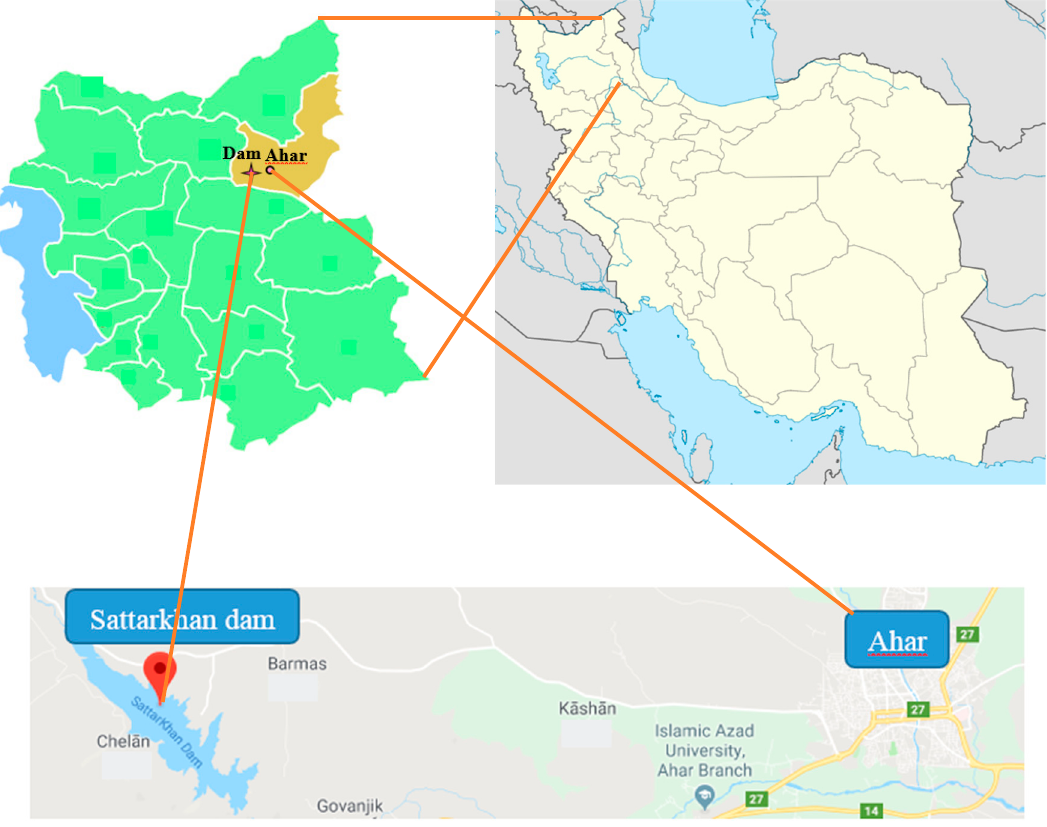
Figure 1. Location of Sattarkhan Dam.